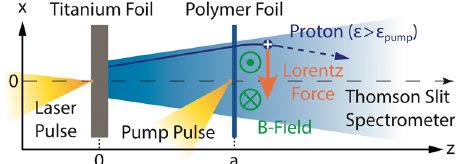
FIG. 10. Deflection of a single proton at the rear side of the polymer foil due to the influence of the ð v Lorentz